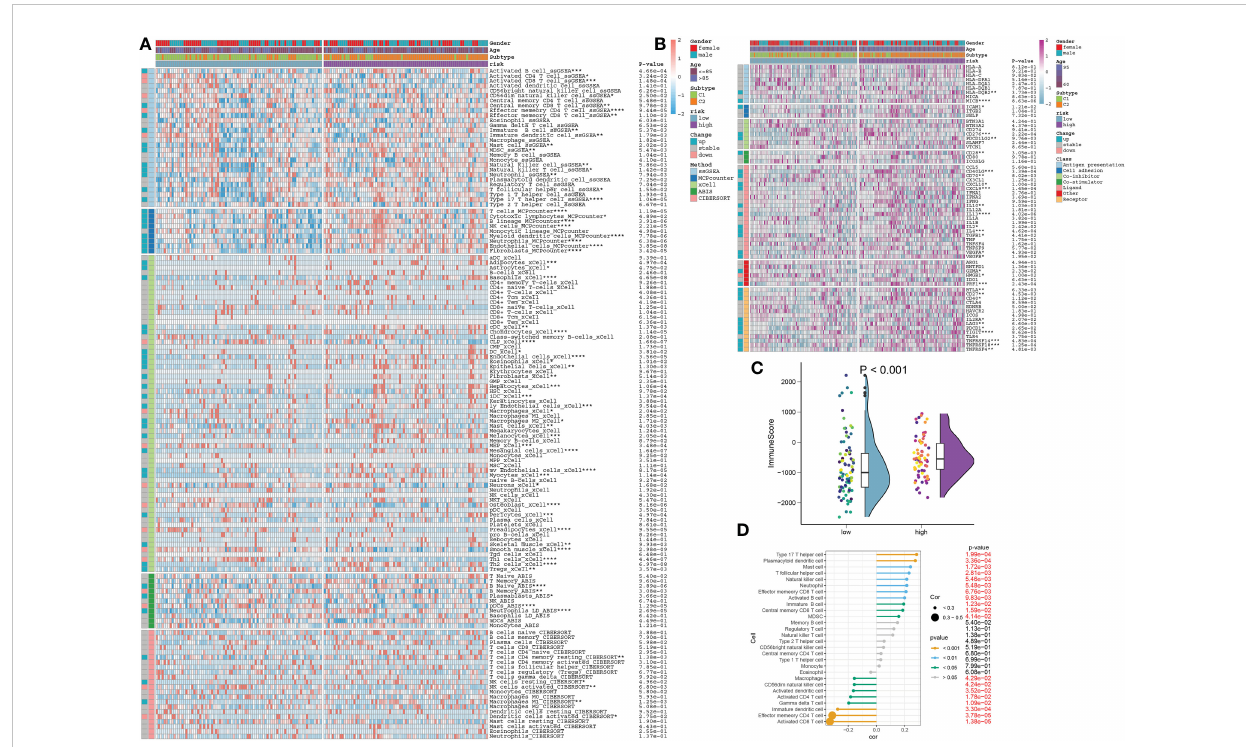
FIGURE 12 The immunological characteristics in AD patients at low and high risk. (A) Heatmap displaying the expression pro fi les of in fi ltrating immune cells between low- and high-risk AD patients based on the ssGSEA, MCPcounter, xCell, ABIS, and ESTIMATE algorithms. Age, gender, and DDR subtypes are displayed as patient annotations. * p < 0.05, ** p < 0.01, *** p < 0.001, **** p < 0.0001. (B) Heatmap displaying the expression pro fi les of immunoregulatory subgroup genes in AD patients at low and high risk. Age, gender, and DDR subtypes are displayed as patient annotations. * p